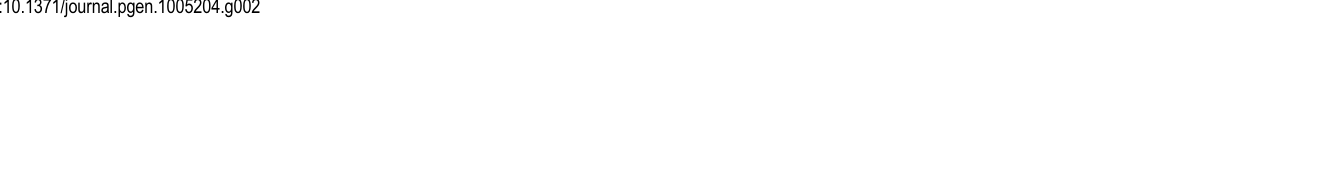
PLOS Genetics | DOI:10.1371/journal.pgen.1005204 May 28,